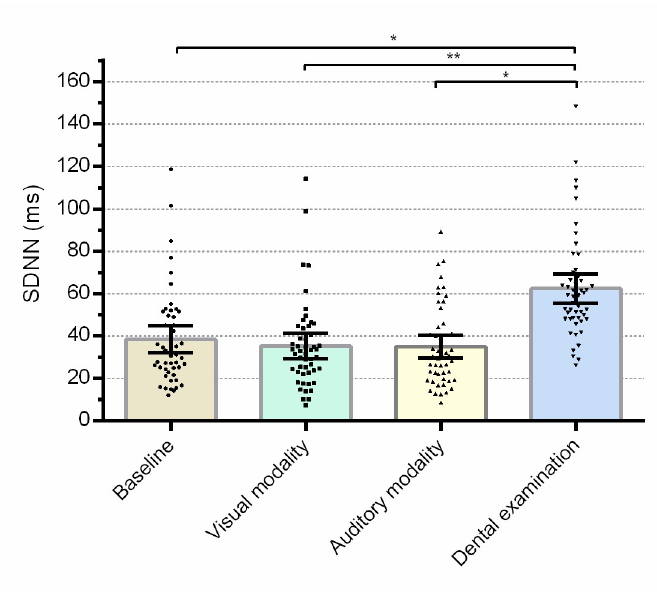
Fig 3. Mean heart rate variability as SDNN during different experimental conditions. Error bars indicate a 95% confidence interval; � p < 0.001; �� p < 0.05; units are in milliseconds.